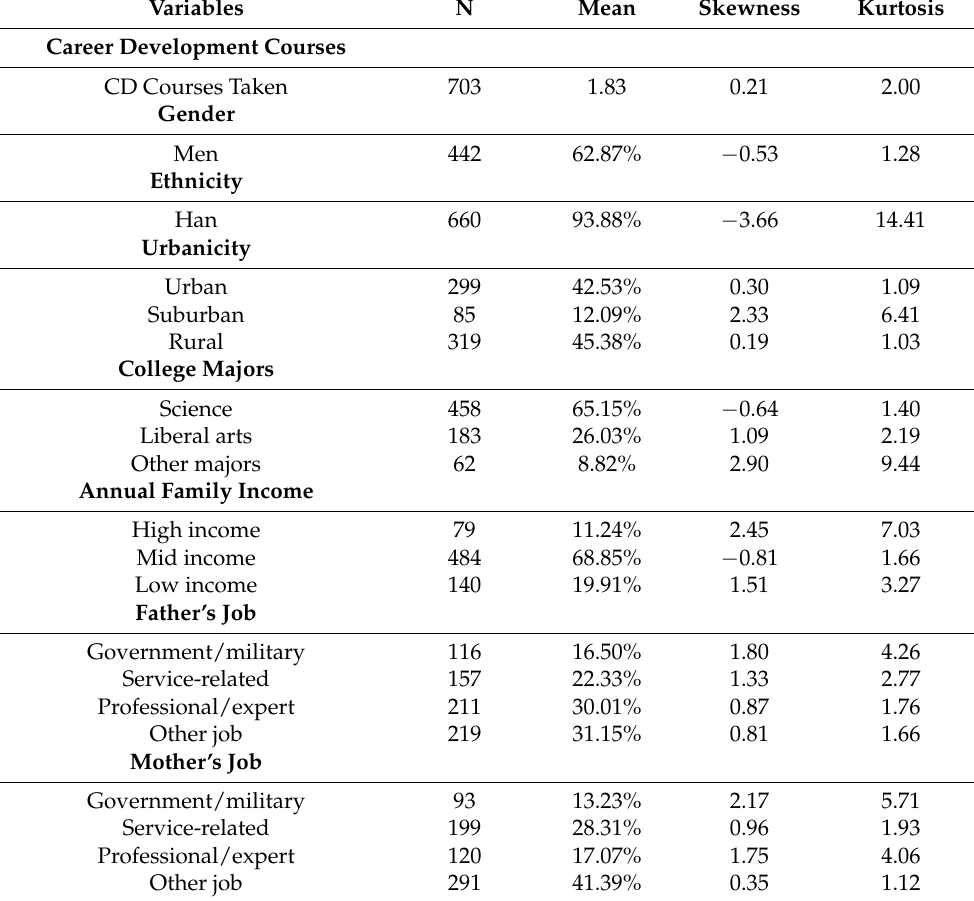
Table 1. Descriptive statistics of students’ career course taking and demographic